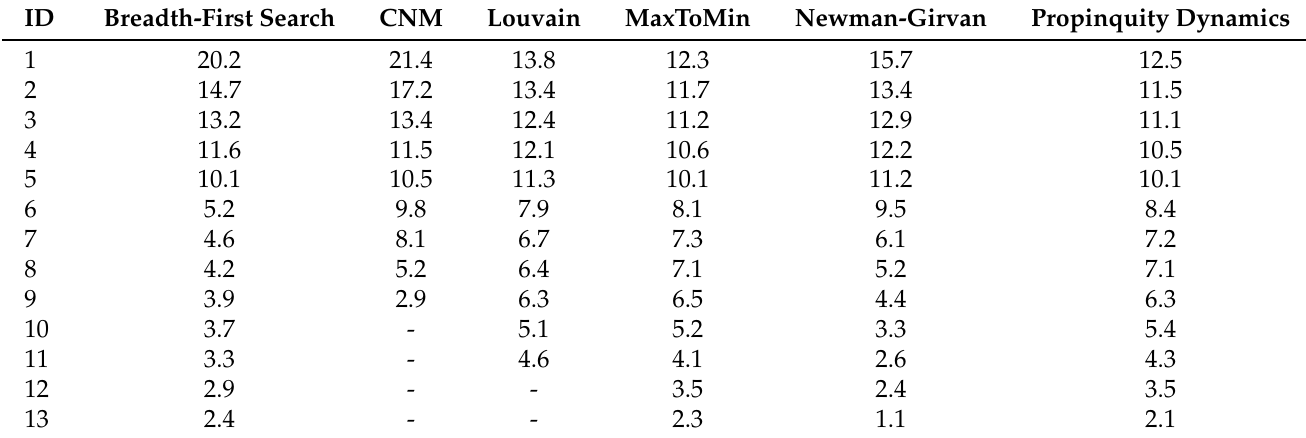
Table 6. Community range (%) of Twitter Graph.